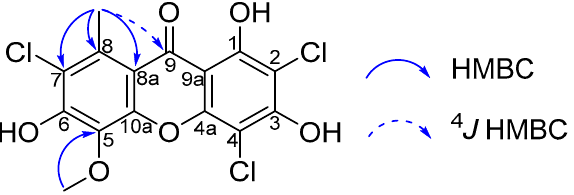
Figure 1. Complete set of HMBC correlations of 1 .